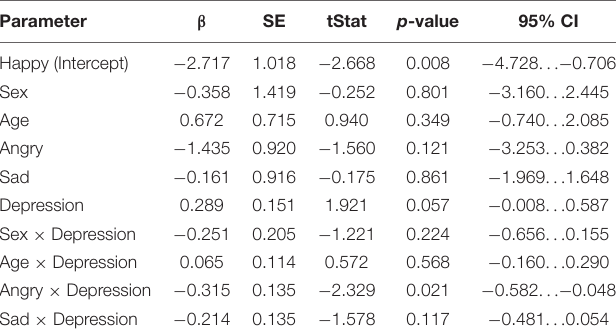
TABLE 4 | Results of the linear mixed-effects regression model (DF = 162) in the late time window (350–450